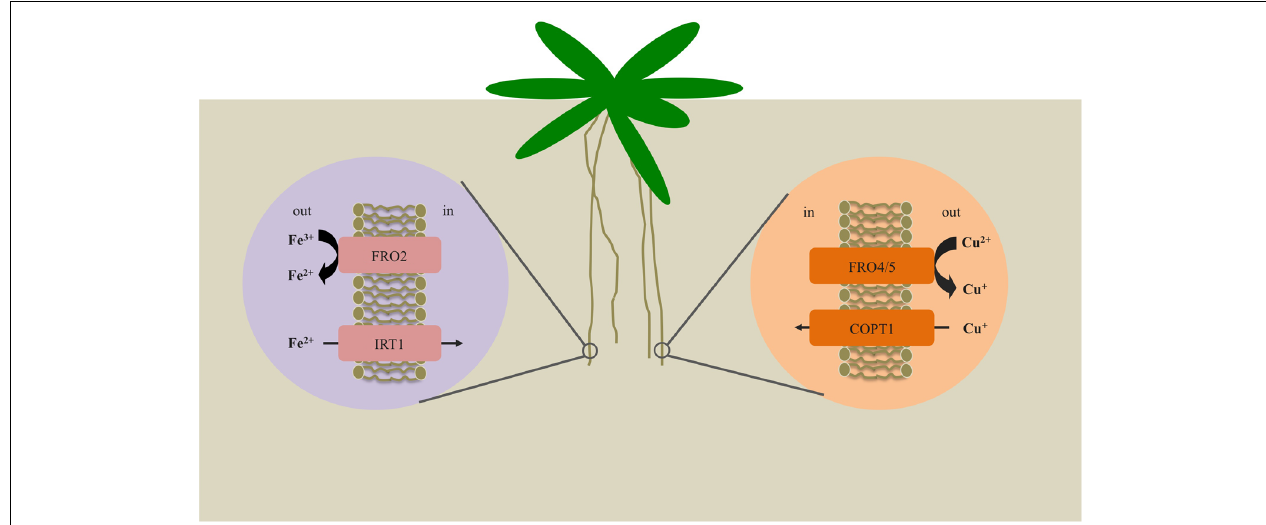
FIGURE 1 | Mechanisms for iron and copper uptake by Arabidopsis roots. Under iron-deficient conditions, expression of FRO2 and IRT1 is enhanced. FRO2 serves to reduce solubilized Fe 3 + to Fe 2 + , which is then transported